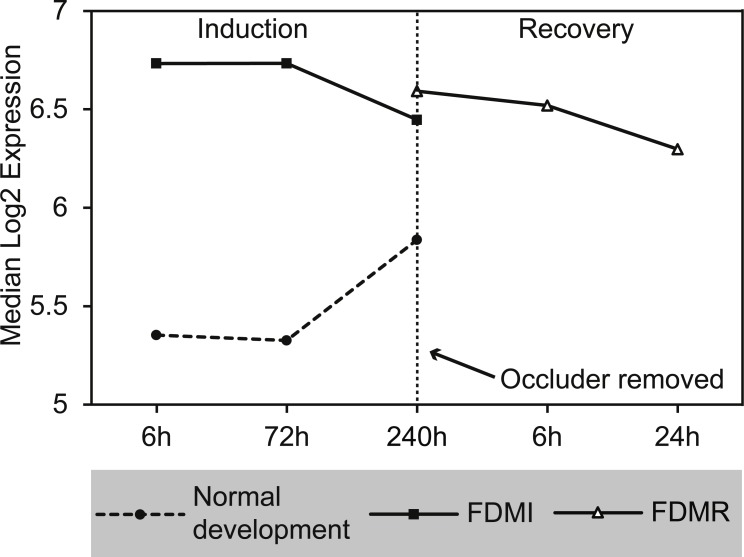
Median expression of core genes in the bile acid and bile salt metabolism pathway during FDM.Graphs shows median change of the core genes during normal ocular development, FDMI, and FDMR. This pathway was found to be significant for FDMI (left, solid line) and FDMR (right, solid line) but not in normal development. Note: Median expression value was calculated based on core genes identified in each experimental group. This pathway was not significantly altered during normal ocular development but data are shown for comparison purposes (dotted line).